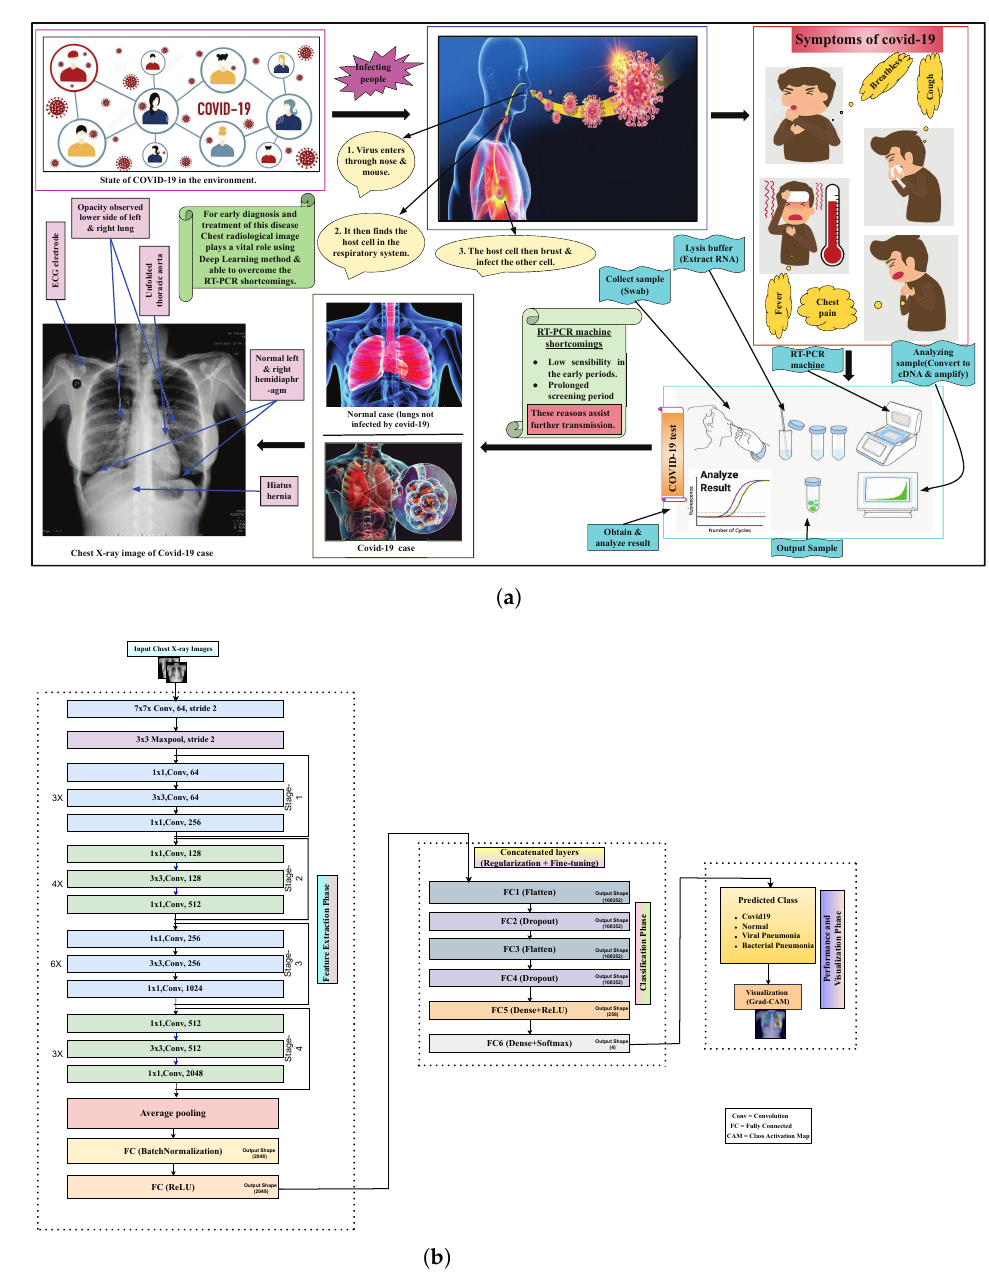
Figure 1. Overview and detection scheme of COVID-19. ( a ) Overview of COVID-19 state in the environment, symptoms, testing, identification with confirmed COVID-19 patient’s chest X-ray sample. ( b ) Modified ResNet50V2 for COVID detection where the 1st part is considered as feature extraction part and then the 2nd part is considered as a classification of different cases images, and lastly, the 3rd part is considered as performance and visualization of the X-ray images